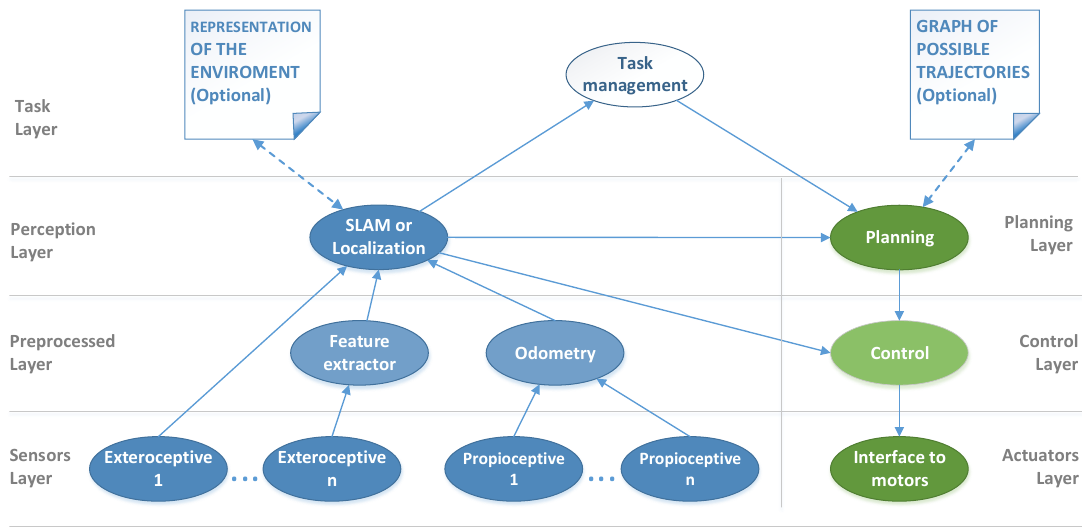
Figure 1. Proposed framework design. Each node represents a software module, and each solid line represents a communication channel between modules. The dashed lines represent optional channels that might connect the localization module with a map of the environment and the planning module with a map of trajectories. The existence of these optional channels depends on the concrete localization and planning algorithms used. The different modules are organized in abstraction layers (sensors, preprocessed...) as well as in conceptual blocks denoted by colours: perception (blue nodes), motion (green nodes) and high-level (white